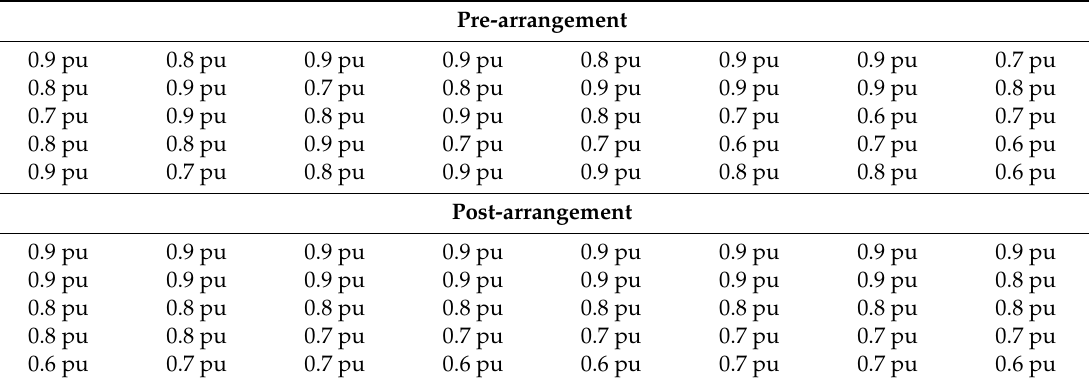
Table 5. PV array configuration for case 2.